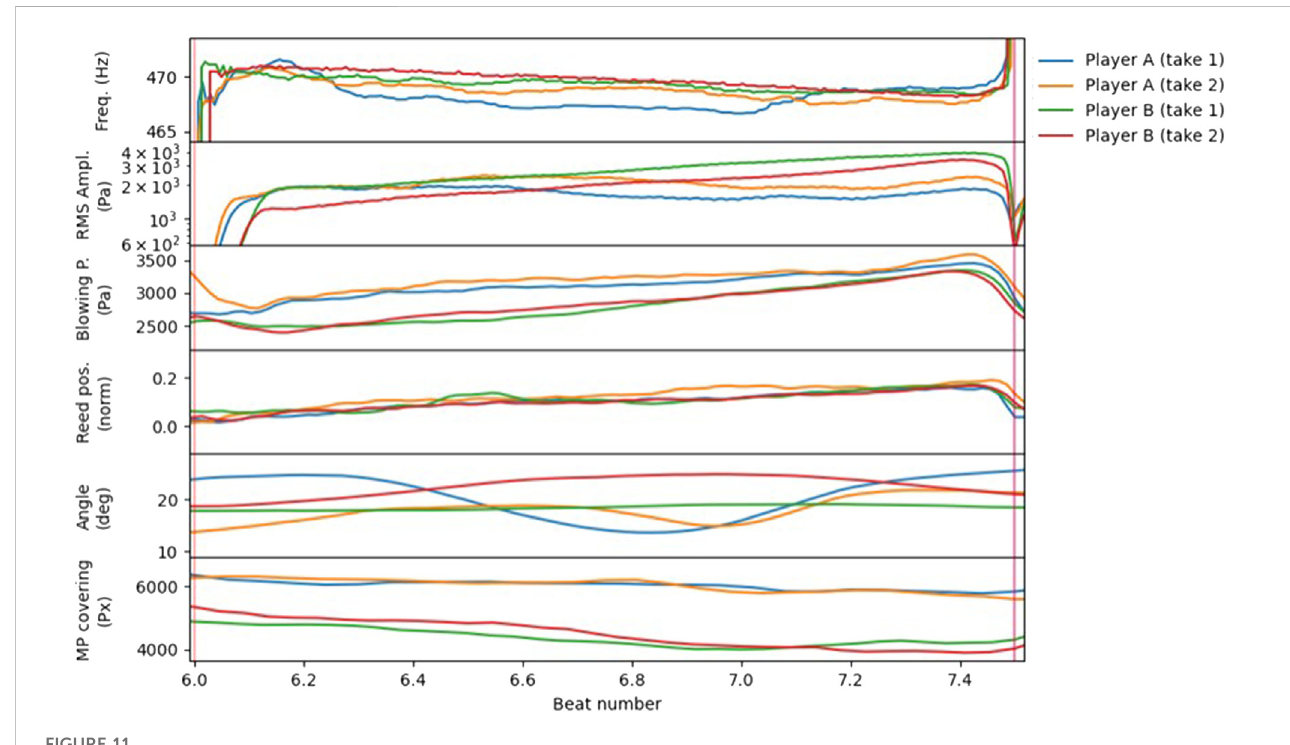
FIGURE 11 One note from Figure 8 shown on an expanded time